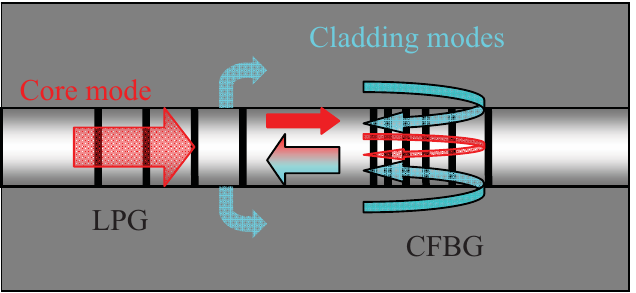
Figure 1. Schematic diagram of hybrid LPG/CFBG refractometer